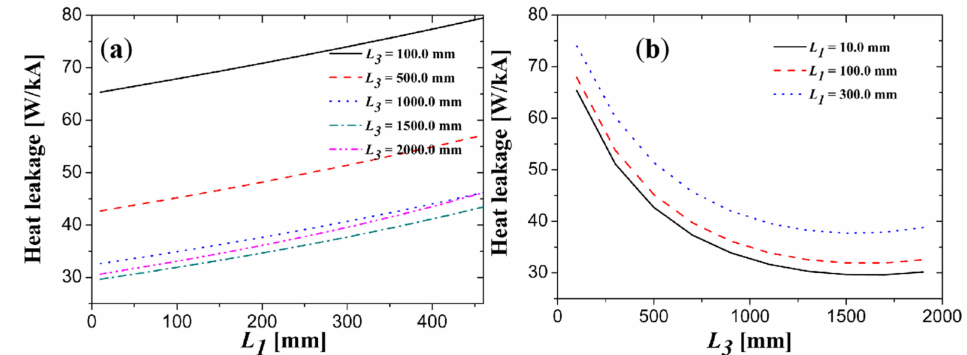
Figure A11. Iteration step two: the coupling influence between B ( L 1 ) and C ( L 3 ) on the cold end heat leakage of PCLs (keeping parameters r 1 = 15.0 mm, r 2 = 20.0 mm, L 2 = 3.5 mm unchanged; in this iteration Q min = 29.6 W/kA). ( a ) The heat leakage vary with B ( L 1 ); ( b )The heat leakage vary with C ( L 3